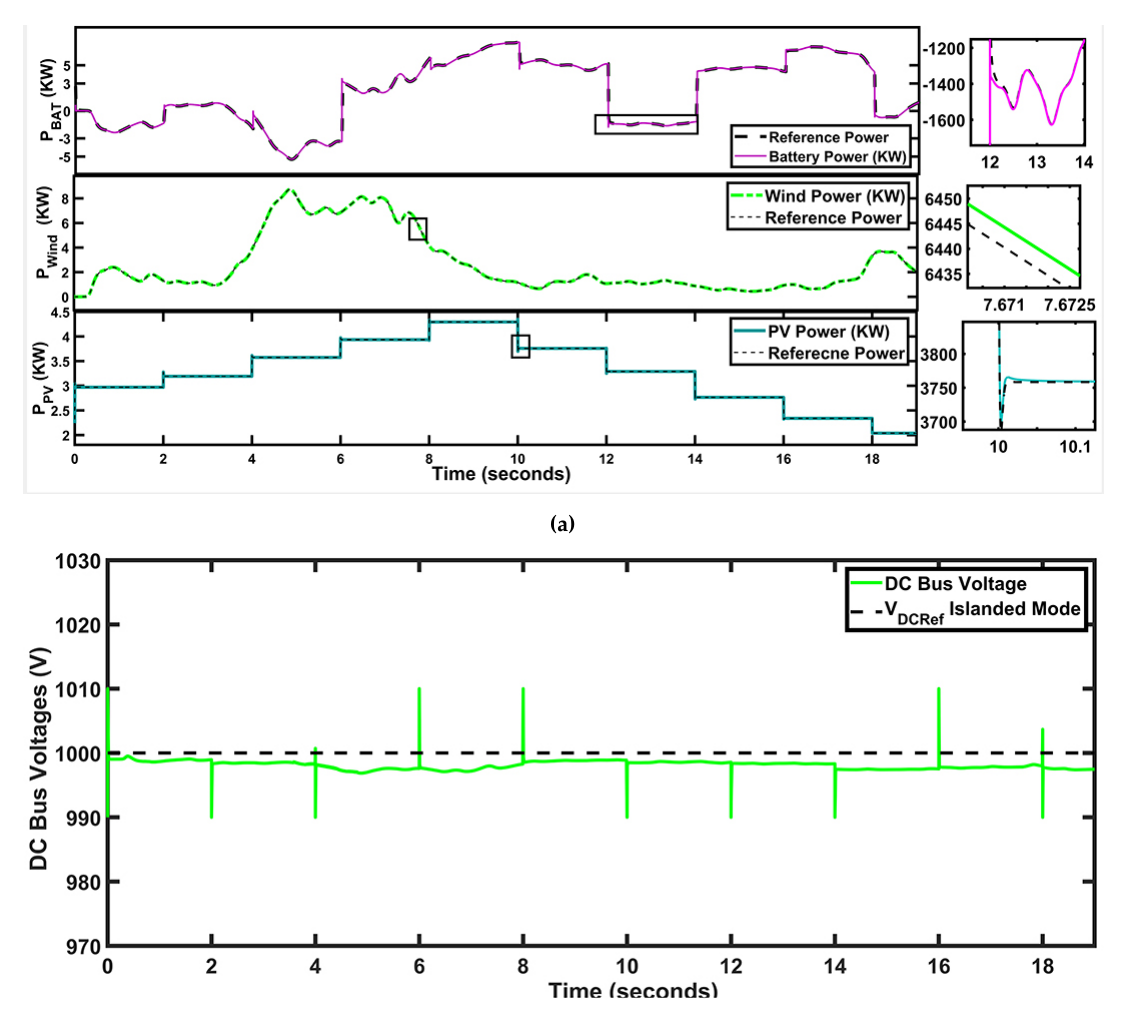
Figure 9. Islanded mode ( a ) Power of energy sources ( b ) DC bus voltage.